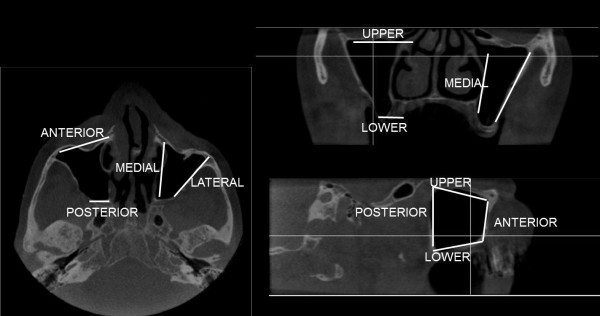
The locations of the abnormalities were recorded using orthogonal view of maxillary sinus.